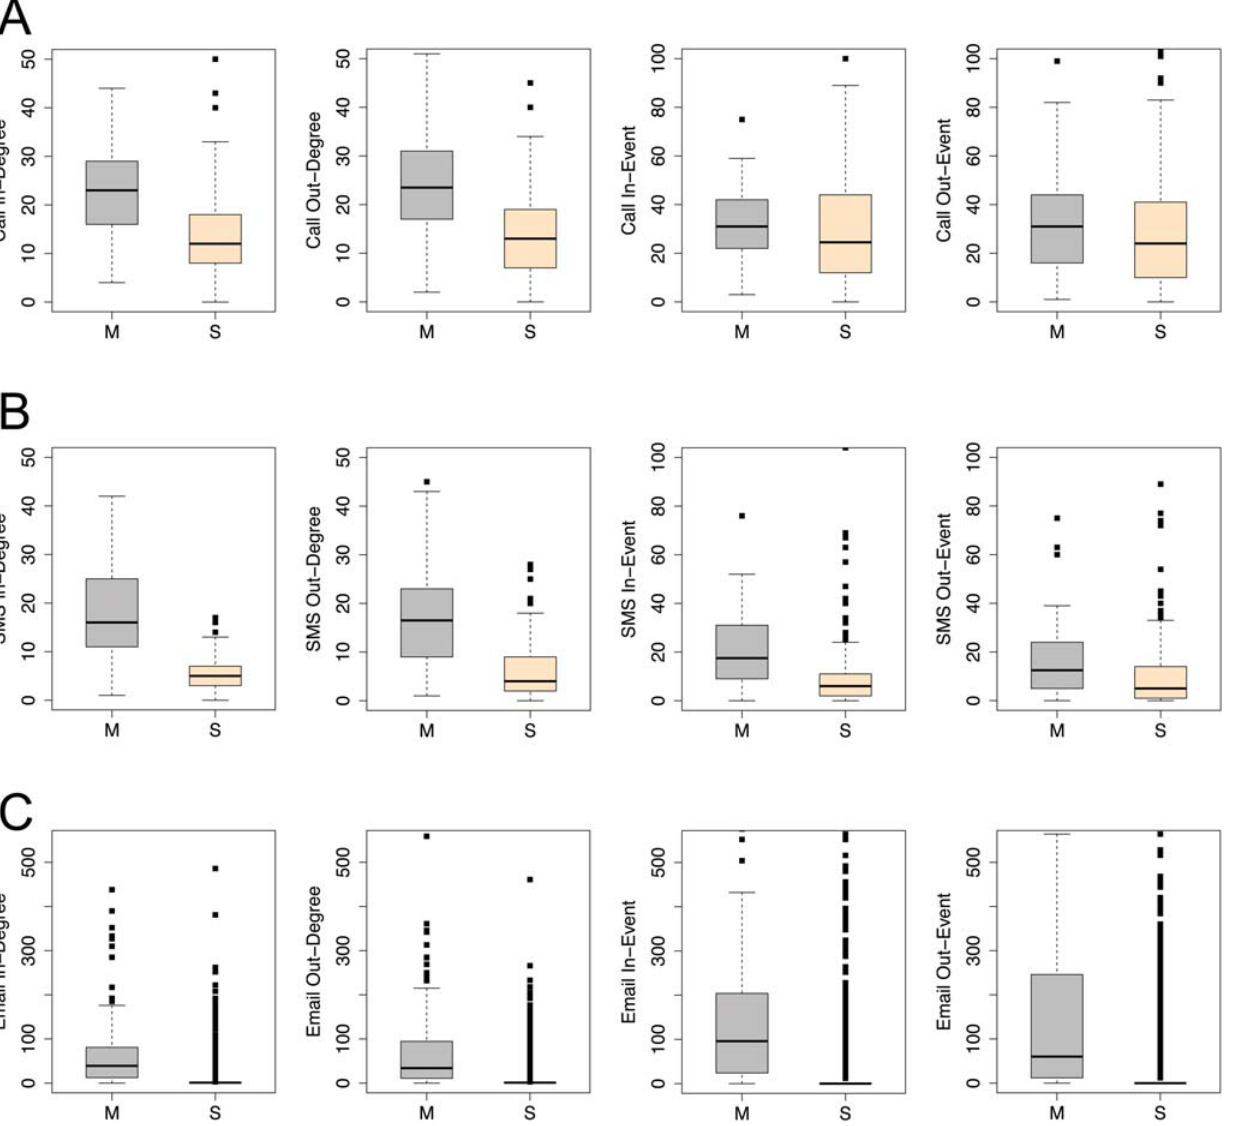
Fig 1. Communication Attributes vs. Social Status. (A). CALL attributes; (B). SMS attributes; (C). EMAIL attributes. Each box plot represents the distribution of the number of attributes per time unit (each month in A and B, and each year in C), including in-degree, out-degree, in-event and